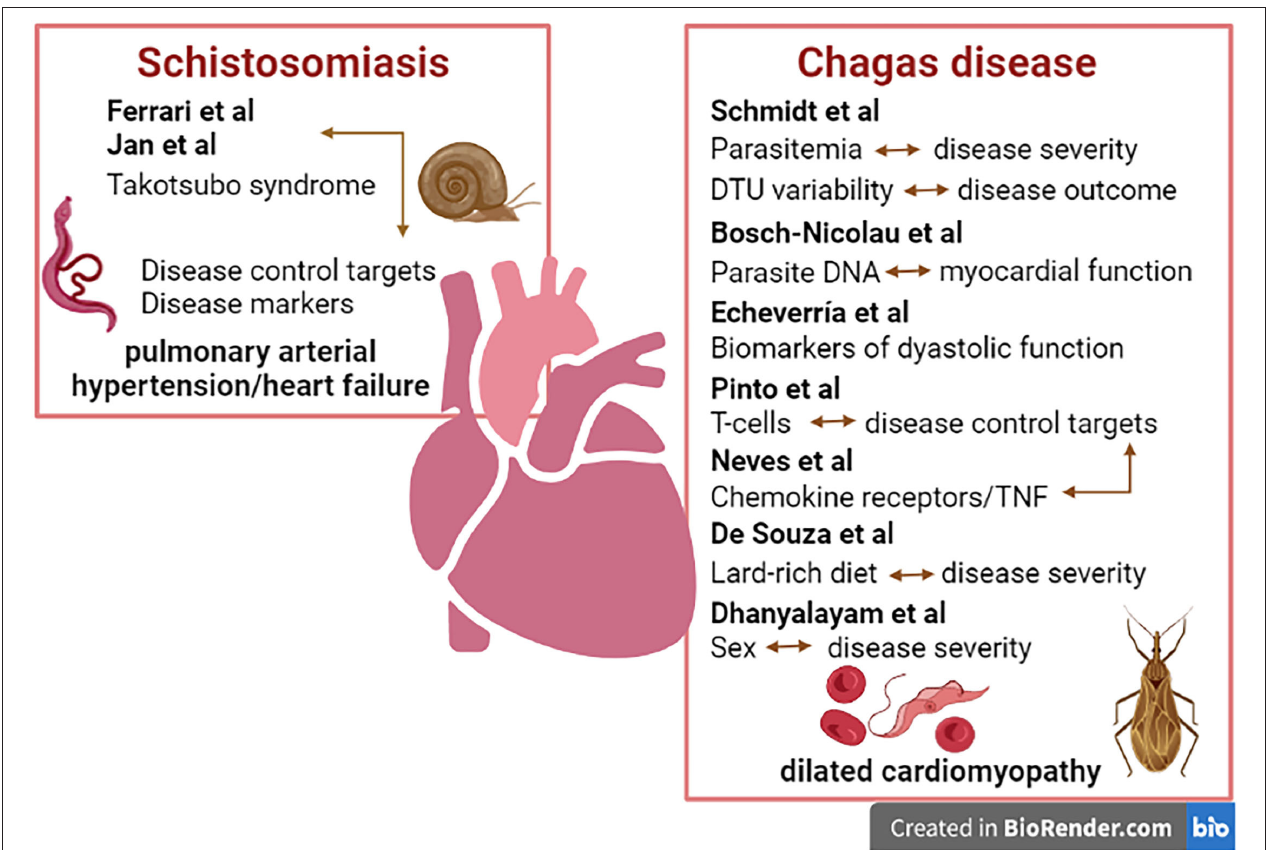
FIGURE 1 | Graphic summary of the infectious cardiomyopathies addressed in this topic.